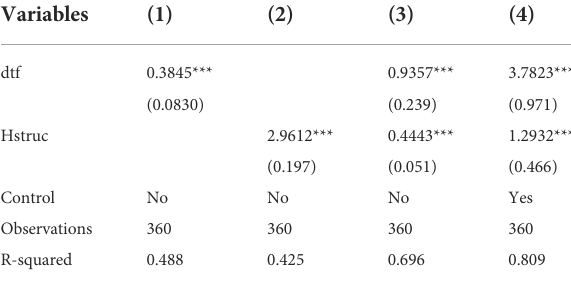
TABLE 11 Estimate results of instrumental variables.